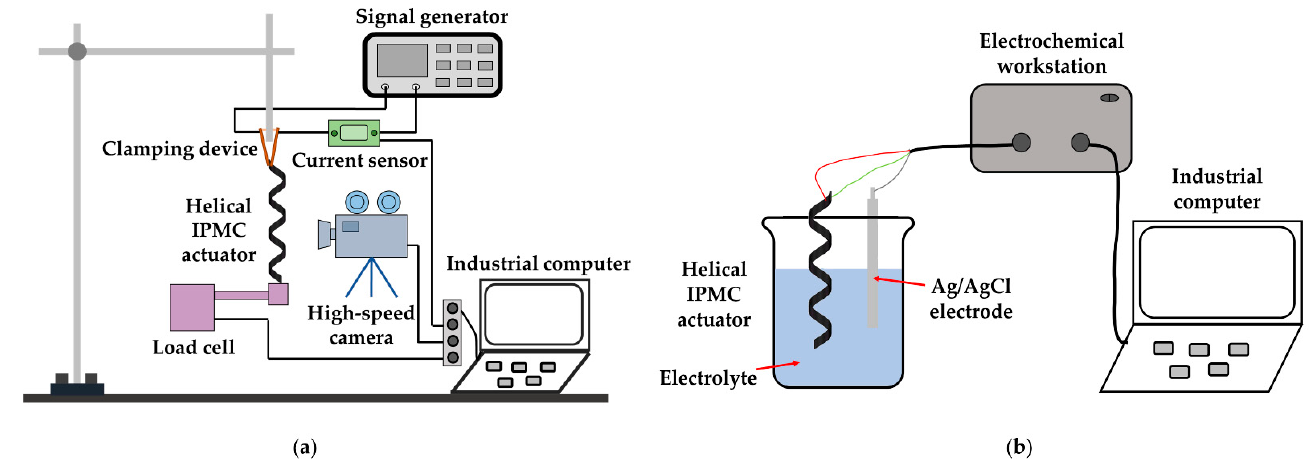
Figure 2. Experimental setup for the helical IPMC actuator: ( a ) electromechanical test; ( b ) electrochemical test.